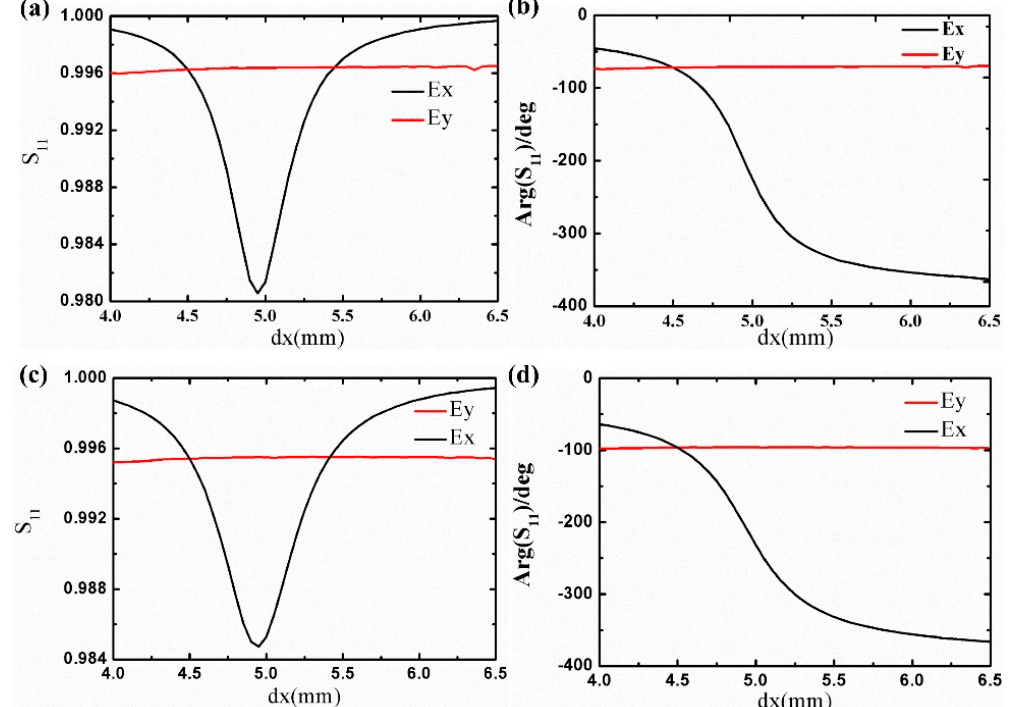
Figure 3. ( a ) The amplitude and ( b ) phase of S 11 of the proposed unit cell as a function of dx. ( c ) The amplitude and ( d ) phase of S 11 of a unit cell without square ring as a function of dx. Here, dy = 4.5 mm.